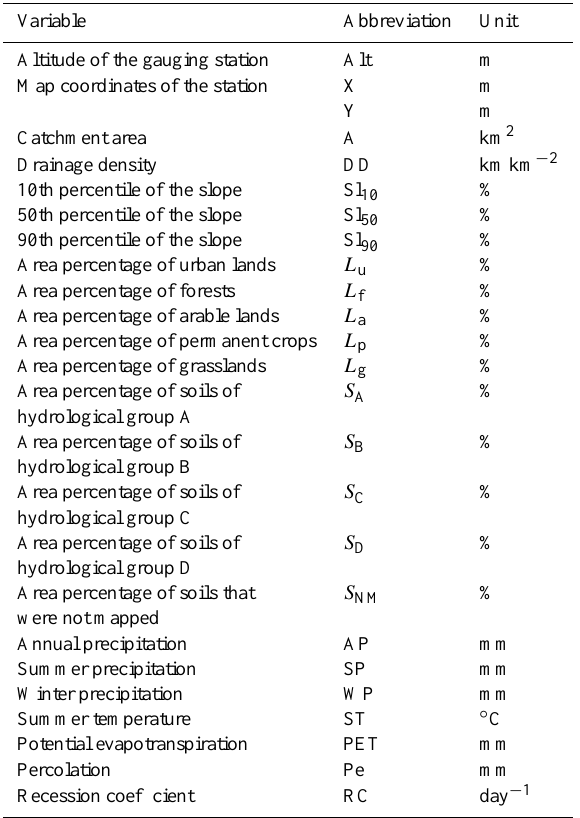
Table 1. The 25 physical and climatic variables considered in this study to describe catchments, along with their abbreviation and unit. “Summer” refers to the July to September period and “win- ter” refers to the October to April